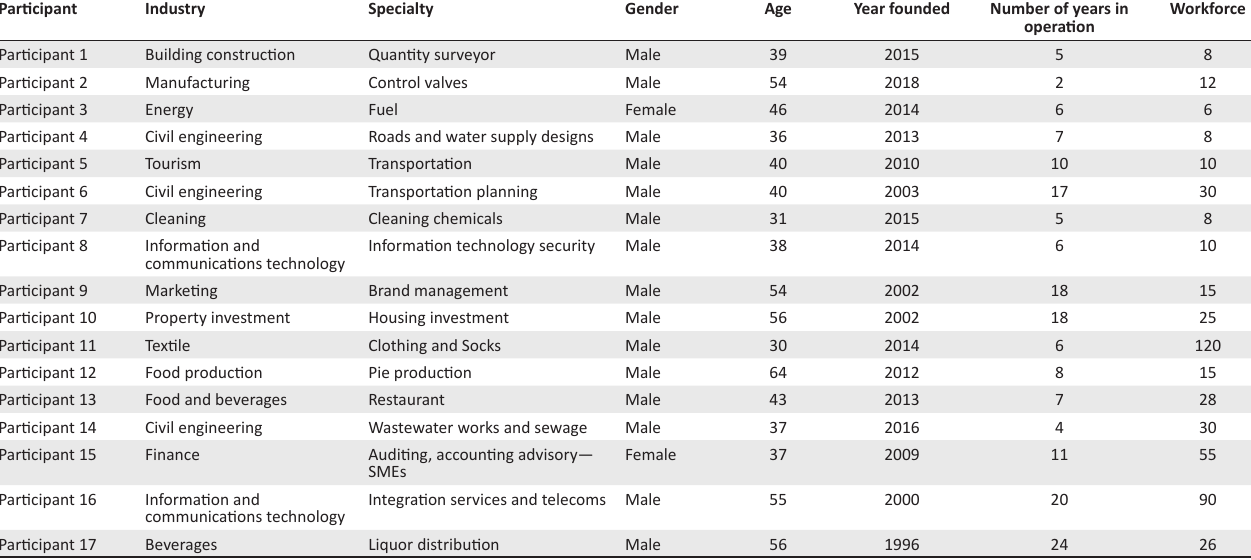
TABLE 1: List of